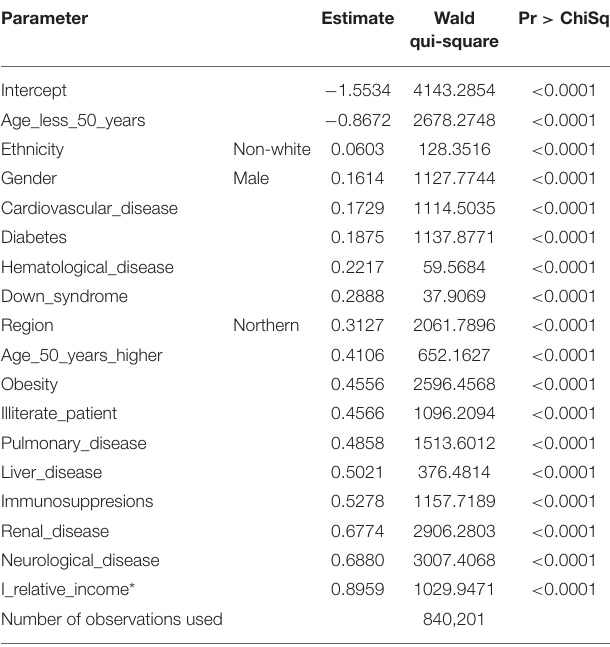
TABLE 3 | Model for mortality rates.